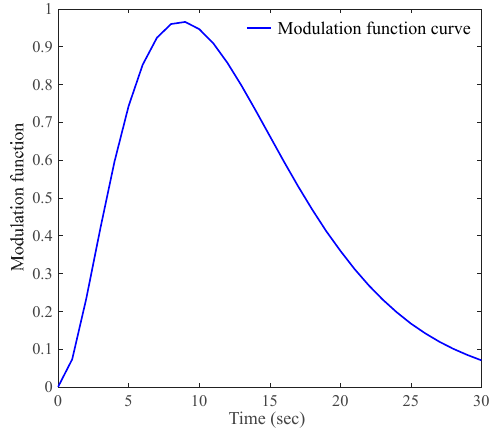
Figure 4. Time–frequency modulation function.